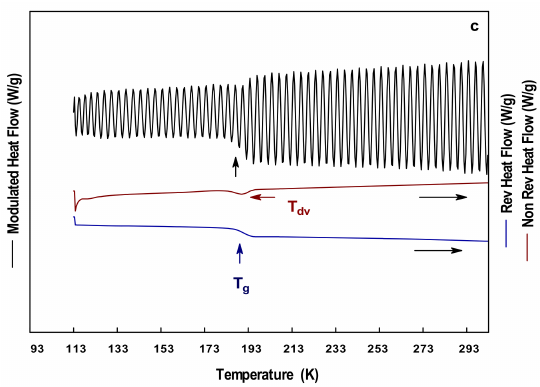
Figure 2. Thermograms of GL at 278 K/min: ( a ) DSC; ( b ) MDSC; and ( c ) SMDSC.